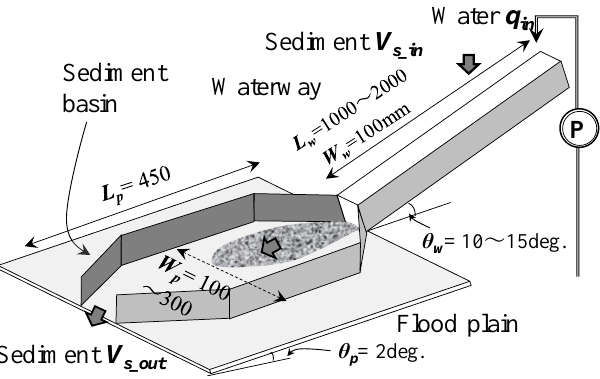
Figure 4. Outline of the experimental set-up.